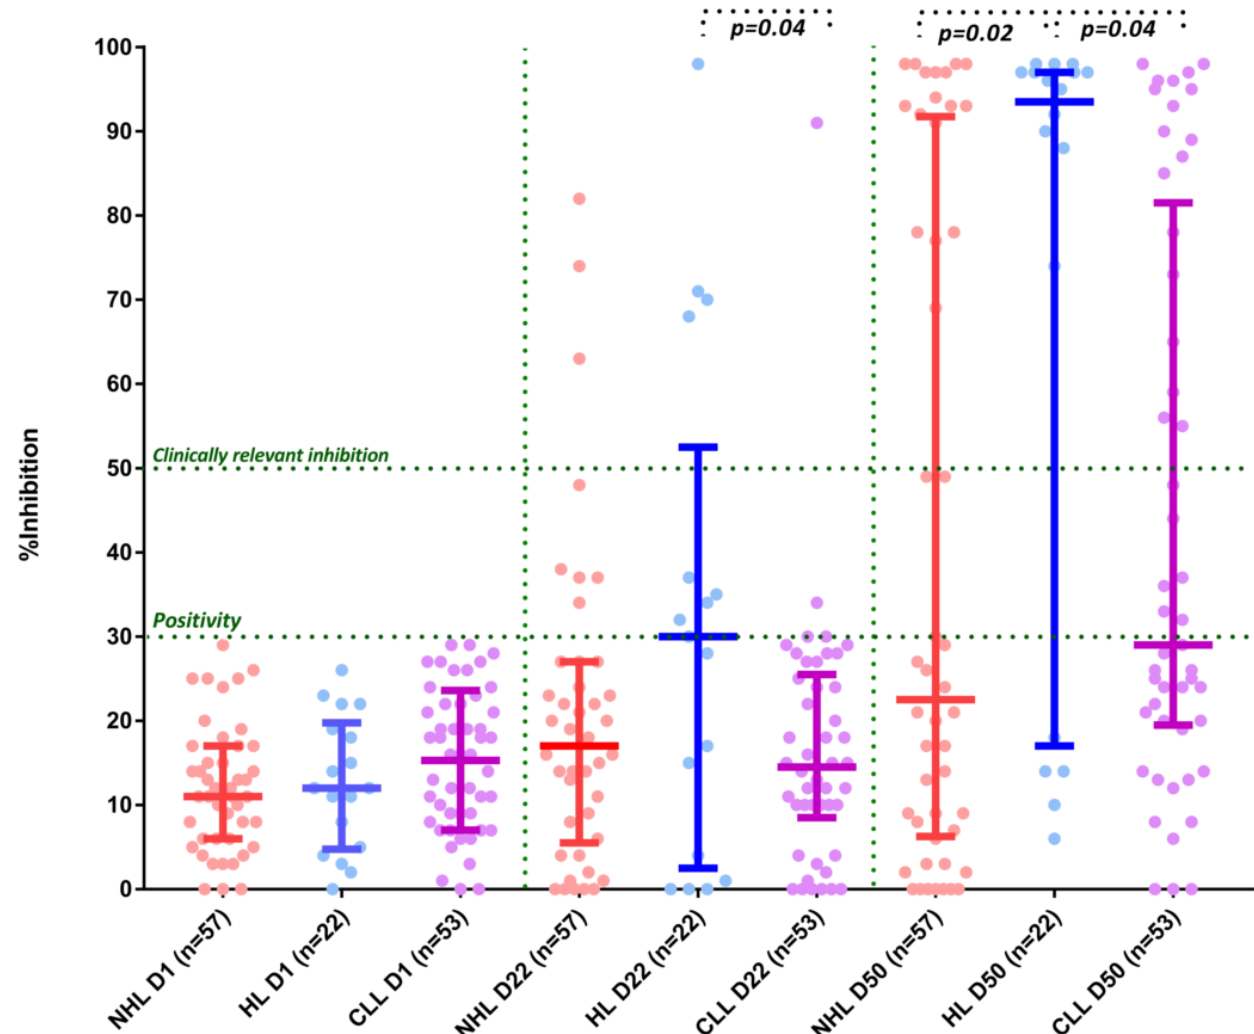
Figure 2. Kinetics of NAbs in non-Hodgkin’s lymphoma (NHL) patients vs Hodgkin’s lymphoma (HL) patients vs chronic lymphocytic leukemia (CLL) patients after vaccination with 2 doses of BNT162b2 (post hoc mixed-model repeated-measures analysis). On D22, patients with HL had significantly higher NAb inhibition titers compared with CLL patients (see text). On D50, patients with HL had higher NAb inhibition titers compared with both NHL and CLL patients (see text).